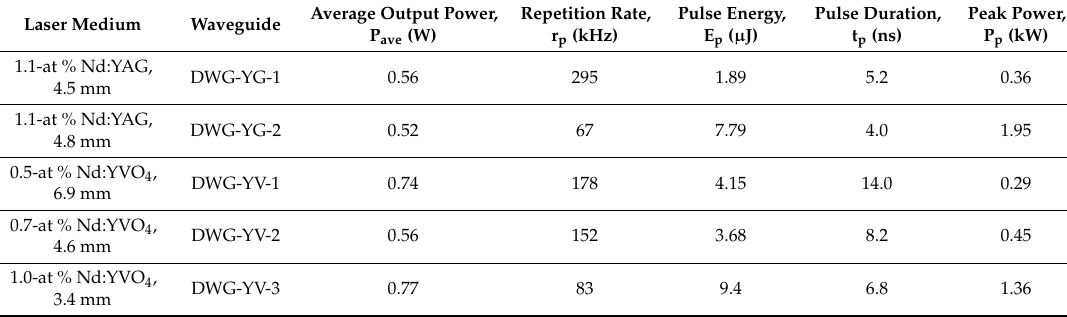
Table 2. Q-switch laser emission at 1.06 µ m, OCM with T = 0.10, Cr 4+ :YAG with T i =